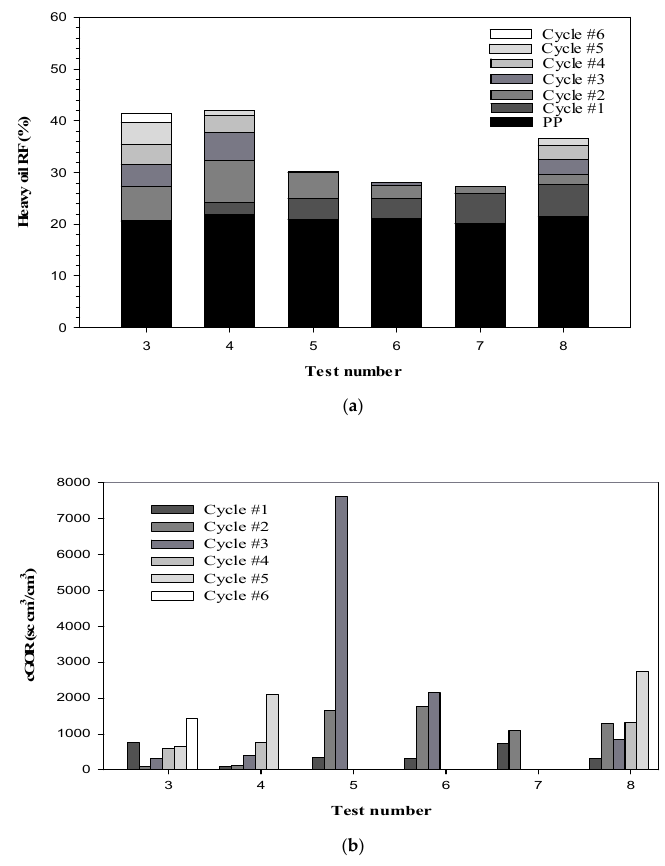
Figure 12. ( a ) Measured heavy oil recovery factors (RFs) during the primary productions (PPs) and in different cycles in Tests #3–8. ( b ) Measured cumulative gas ‒ oil ratio (cGORs) in different cycles of C 3 H 8 -GPC processes at ∆ P EOR = 0.1 and 0.5 MPa (Tests #3 and #4); Cycles #1–3 in CO 2 -GPC process at ∆ P EOR = 0.5 MPa (Test #5); and in different cycles of SA-GPC processes at ∆ P EOR = 0.1, 0.5, and 1.0 MPa (Tests #6 ‒ 8).